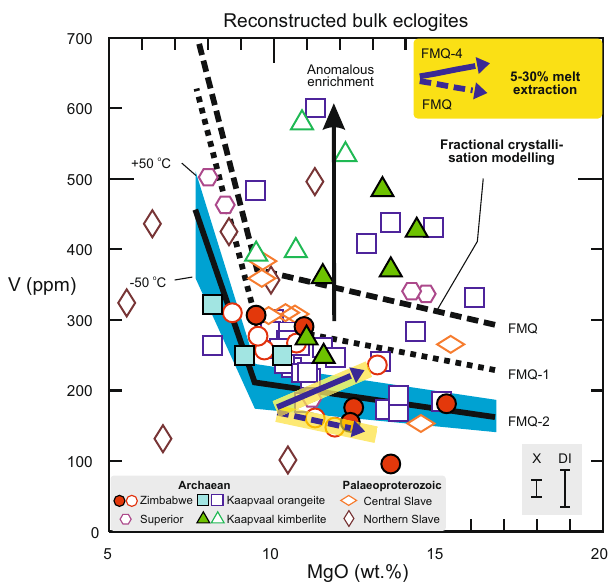
Fig. 5 Estimates of ƒ O 2 of convecting mantle sources from which the oceanic crustal protoliths to eclogites formed. Shown are V abundances (ppm) in reconstructed bulk eclogite xenoliths and DI as a function of MgO content (wt.%), fi ltered to exclude samples with gabbroic cumulate protoliths (conservative cut-off Al 2 O 3 /FeO = 1.7) and, for xenoliths, metasomatism (NMORB-normalised Ce/Yb > 1 and Cr 2 O 3 > 0.1 wt.%). Shown for comparison is the modelled evolution of melts for a mantle potential temperature ( T P ) of 1450°C (olivine crystallisation temperature of 1340 °C) after crystallisation of spinel, olivine and plagioclase from a parental melt formed at a melt fraction of 0.2, appropriate for warmer Archaean spreading ridges, and various ƒ O 2 . A difference of ±50 °C in T P and corresponding crystallisation temperature is shown as blue envelope for Δ log ƒ O 2 (FMQ) = − 2, whereby V becomes more incompatible with increasing temperature 35 , causing the isopleths to shift upward relative to samples. Modelled effect of 30% melt extraction at FMQ-4 and FMQ (as in Fig. 4a) is shown for comparison (purple arrows), illustrating that melt extraction at FMQ-4 biases V abundances toward higher apparent ƒ O 2 whereas at FMQ melt extraction shifts samples with MgO> ∼ 9 wt.% along olivine control lines. Modelling parameters and rationale in Methods; Supplementary Table 3. Error bars for reconstructed bulk rocks show average propagated 1 σ uncertainties on V abundances of 29 ppm for xenoliths and 69 ppm for DI (Methods). Data sources in Supplementary Data